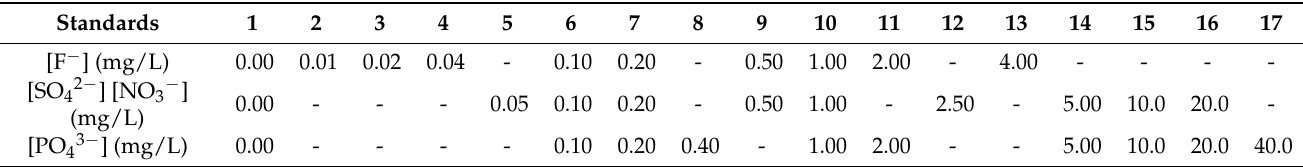
Table A4. The concentrations of the standard solutions used for cement chemical analyses by HPIC.